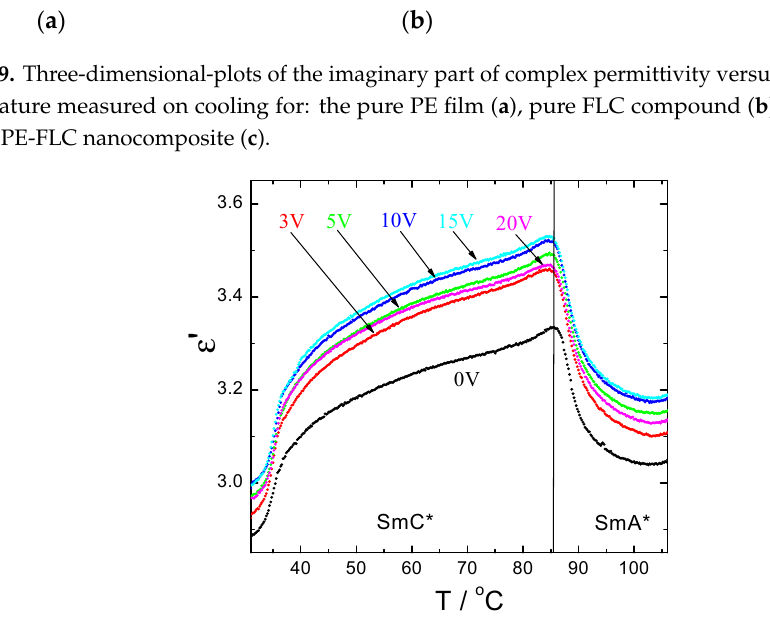
Figure 10. Temperature dependence of real part of complex permittivity measured (at frequency of 2 kHz) on cooling for PE-FLC nanocomposite under d.c. bias field as indicated.